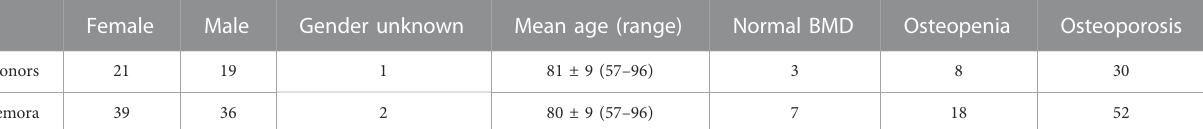
TABLE 1 Description of donor demographics.